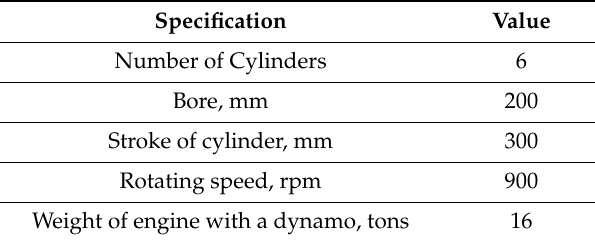
Figure 2. Photograph of the targeted marine diesel engine (6DK-20e, maximum power = 1071 kW). Table 1. Specifications of the marine diesel engine (6DK-20e).